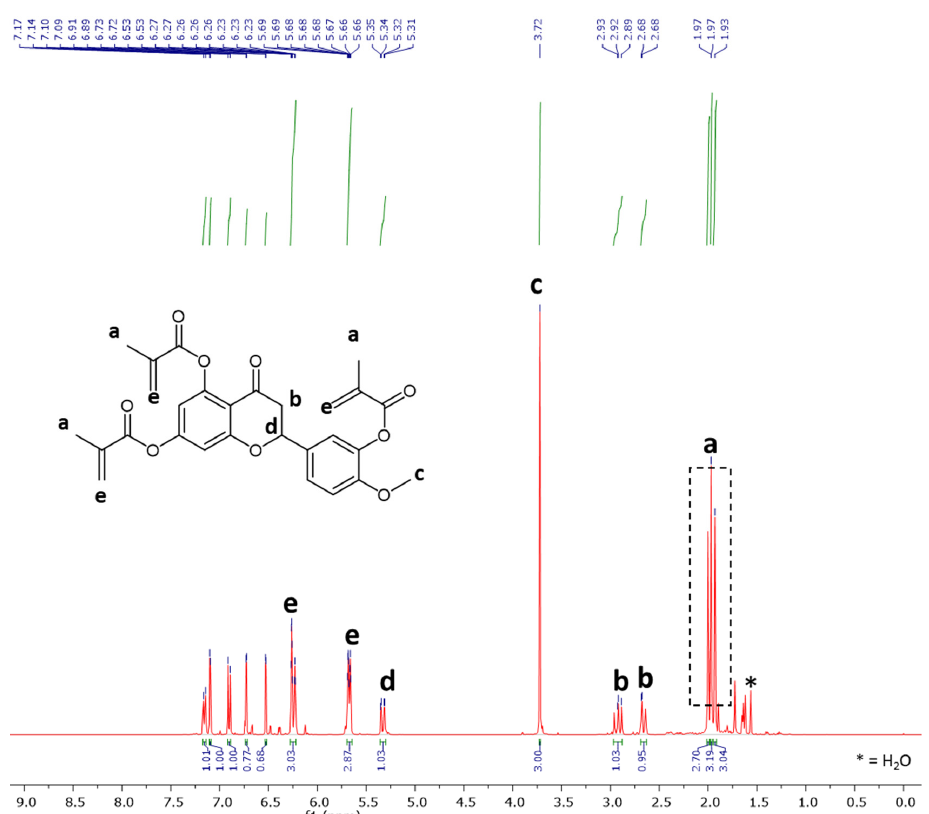
Materials 2021 , 14 , x FOR PEER REVIEW Figure 1. 1 H NMR spectroscopy spectrum of HTM. Figure 1. 1 H NMR spectroscopy spectrum of HTM.